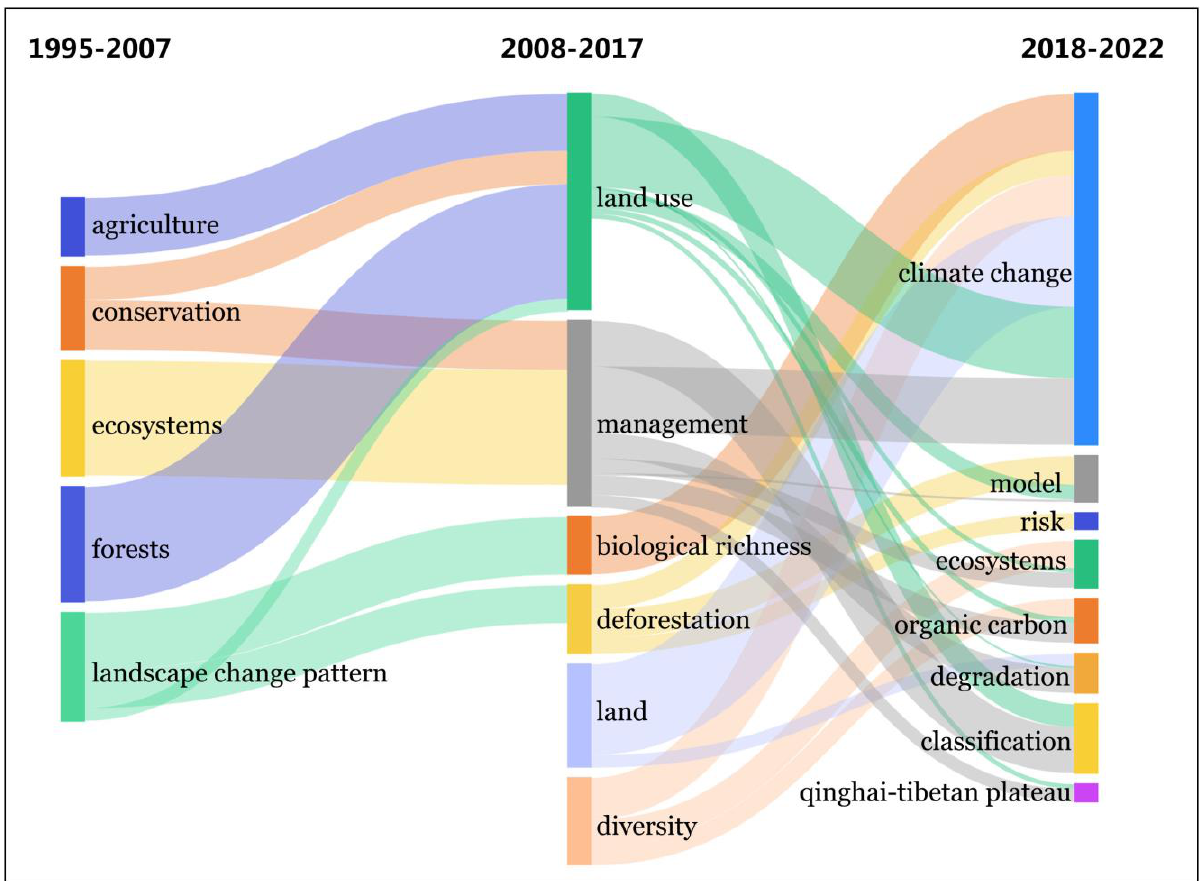
Figure 12. Thematic evolution of studies considering the ecological and environmental effects of land use and cover changes (LUCC) on the Qinghai – Tibetan Plateau (QTP) from 1995 to 2022. (1) In terms of the impact of expanding cultivated lands and deforestation, the stud- ied evolutionary pathways included: 1 (cid:13) Agriculture → land use; 2 (cid:13) forests → land use; 3 (cid:13) landscape change pattern → land use → climate change; 4 (cid:13) deforestation → risk. The QTP is ecologically fragile and economically underdeveloped, and the topographic con- ditions of the region limit the increase of productivity levels. As a result, irrational